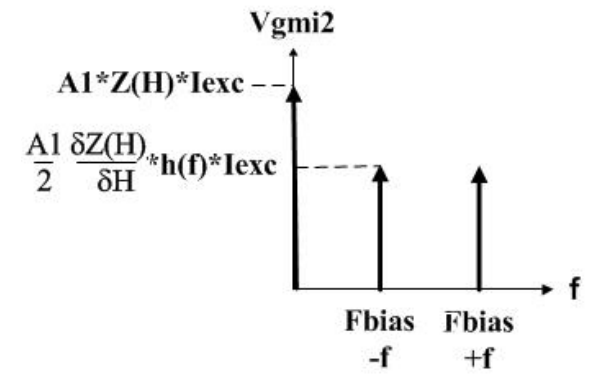
Figure 7. Frequency domain of GMI signal (Vgmi2) after multi- plication by clock at Fexc.